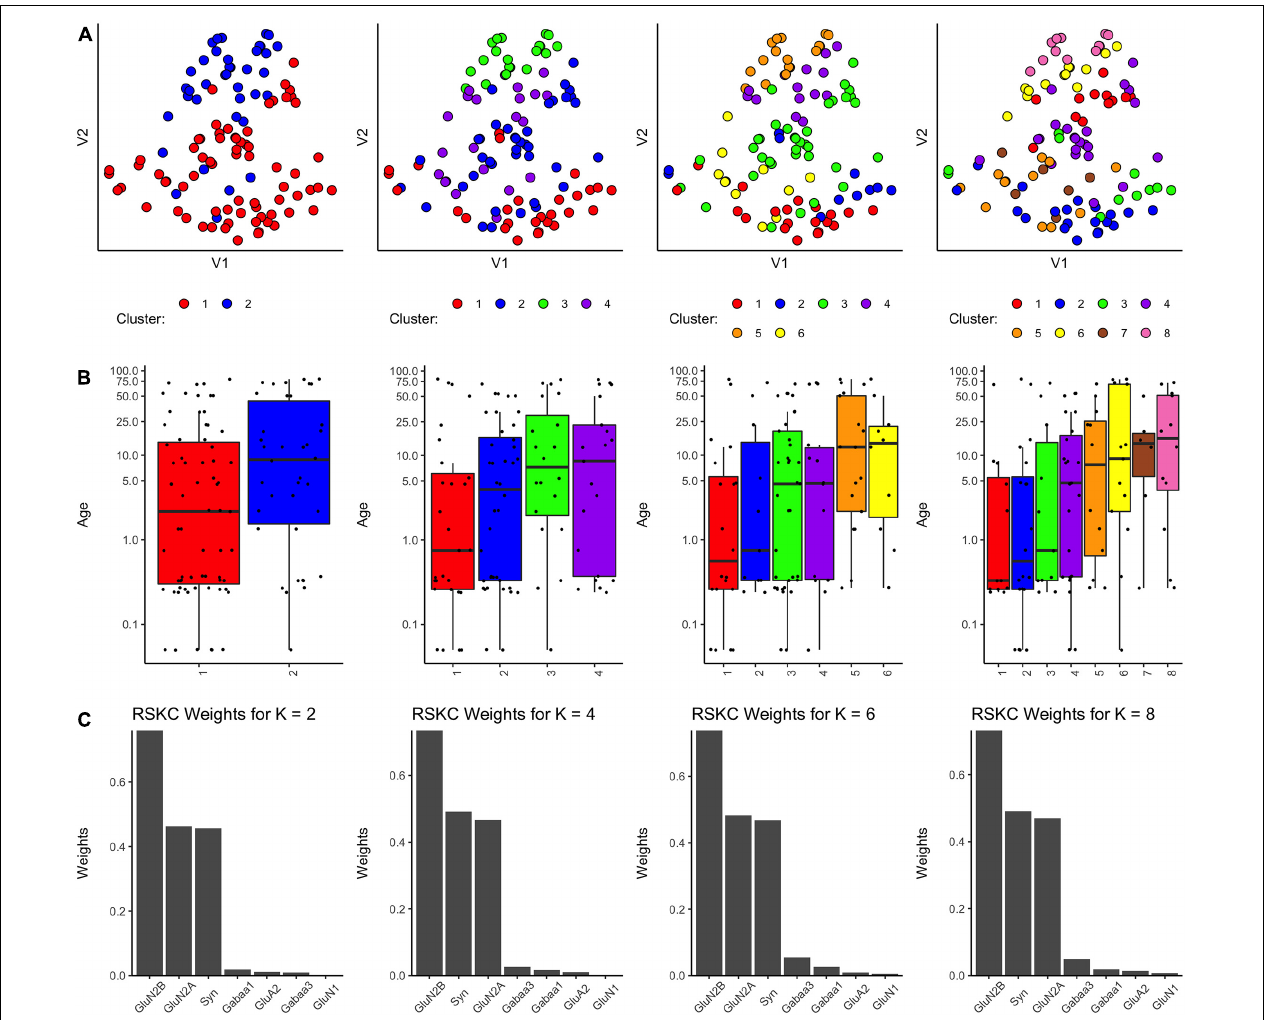
FIGURE 4 | Age-related clustering of seven synaptic proteins for a single iteration. Expression data from seven synaptic proteins were input into RSKC and used to identify k = 2, 4, 6, and 8 case clusters. For each k value, three plots were constructed: (A) 2D tSNE scatter plots showing samples color-coded by their cluster designations, (B) box plots displaying the distribution of ages for each cluster, and (C) a bar graph representing the RSKC weights for all seven